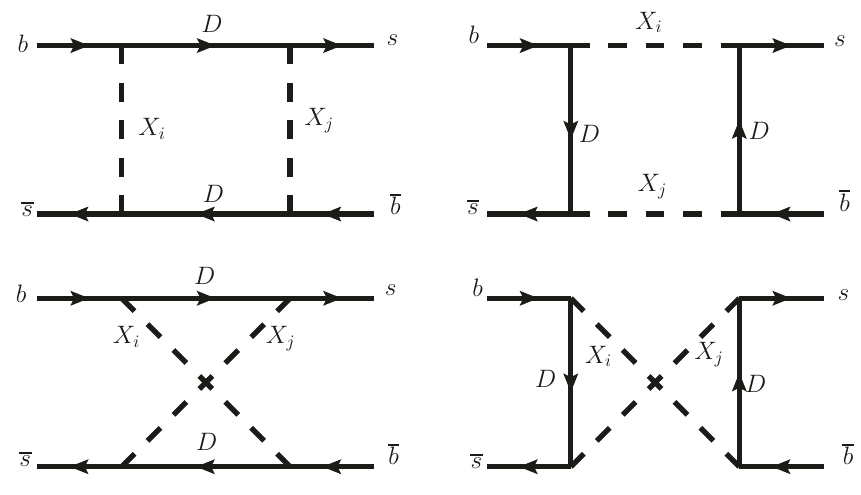
(cid:22) B s mixing with i; j = I; R (cid:0)